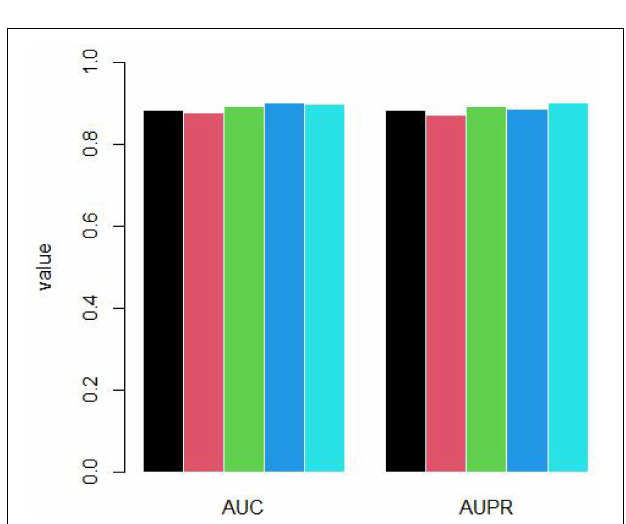
FIGURE 3 | PR curves of different ELM model number.